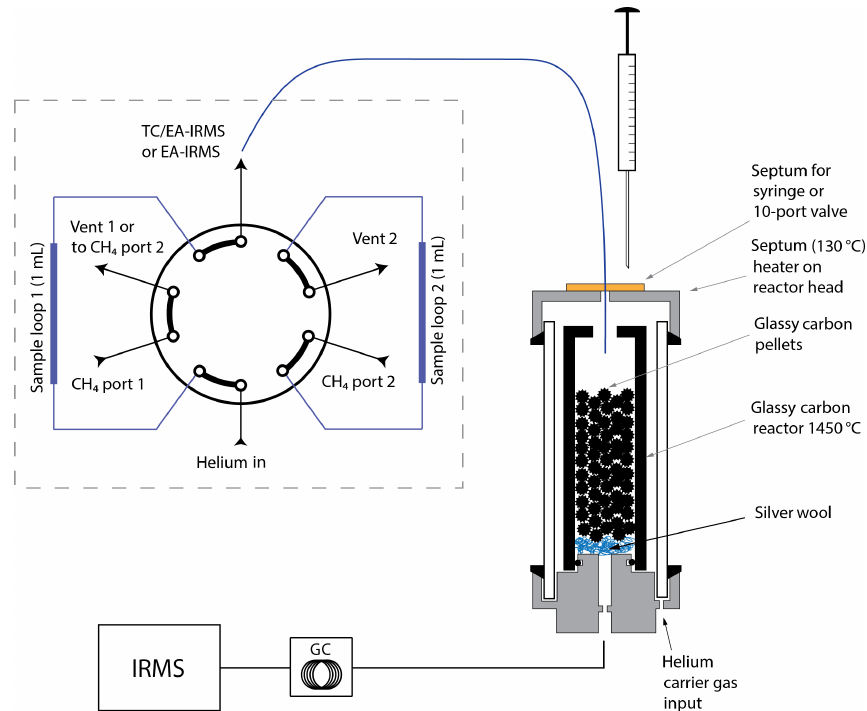
Figure 2. Configuration of manual the two-position 10-port valve with two 1mL sample loops shown in grey dashed box and TC/EA–IRMS system for δ 2 H–CH 4 calibration. The TC/EA–IRMS reactor (displayed as in Gehre et al., 2004) is fed either by the sample line from the 10-port valve or by the syringe via autosampler (not shown). The size of components is chosen to increase